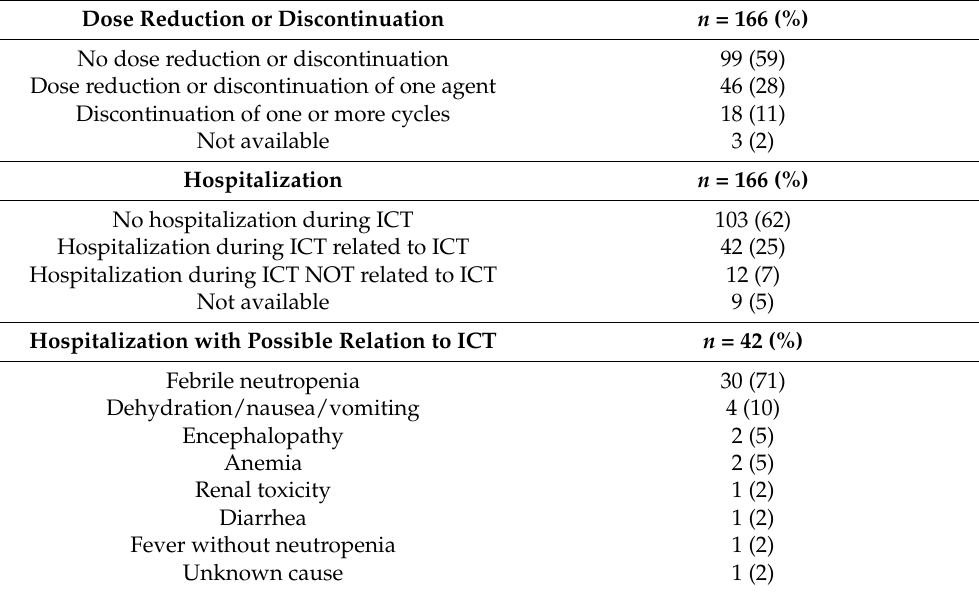
Table 3. Adverse events related to induction